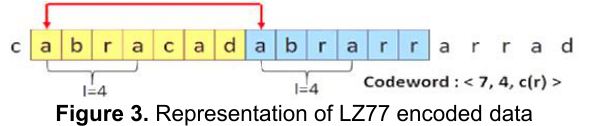
Figure 3. Representation of LZ77 encoded data